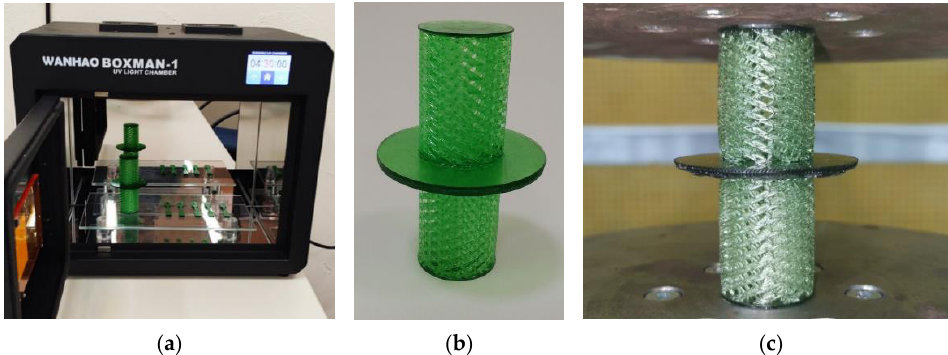
Figure 8. Experimental setup for measuring the static compressive behavior of the 3D-printed joint: ( a ) curing of some parts after their printing, ( b ) an undeformed 3D-printed joint, and ( c ) a deformed joint prototype during the compression test (180 small recesses are printed around the flywheel to help the rotation angle measurements).